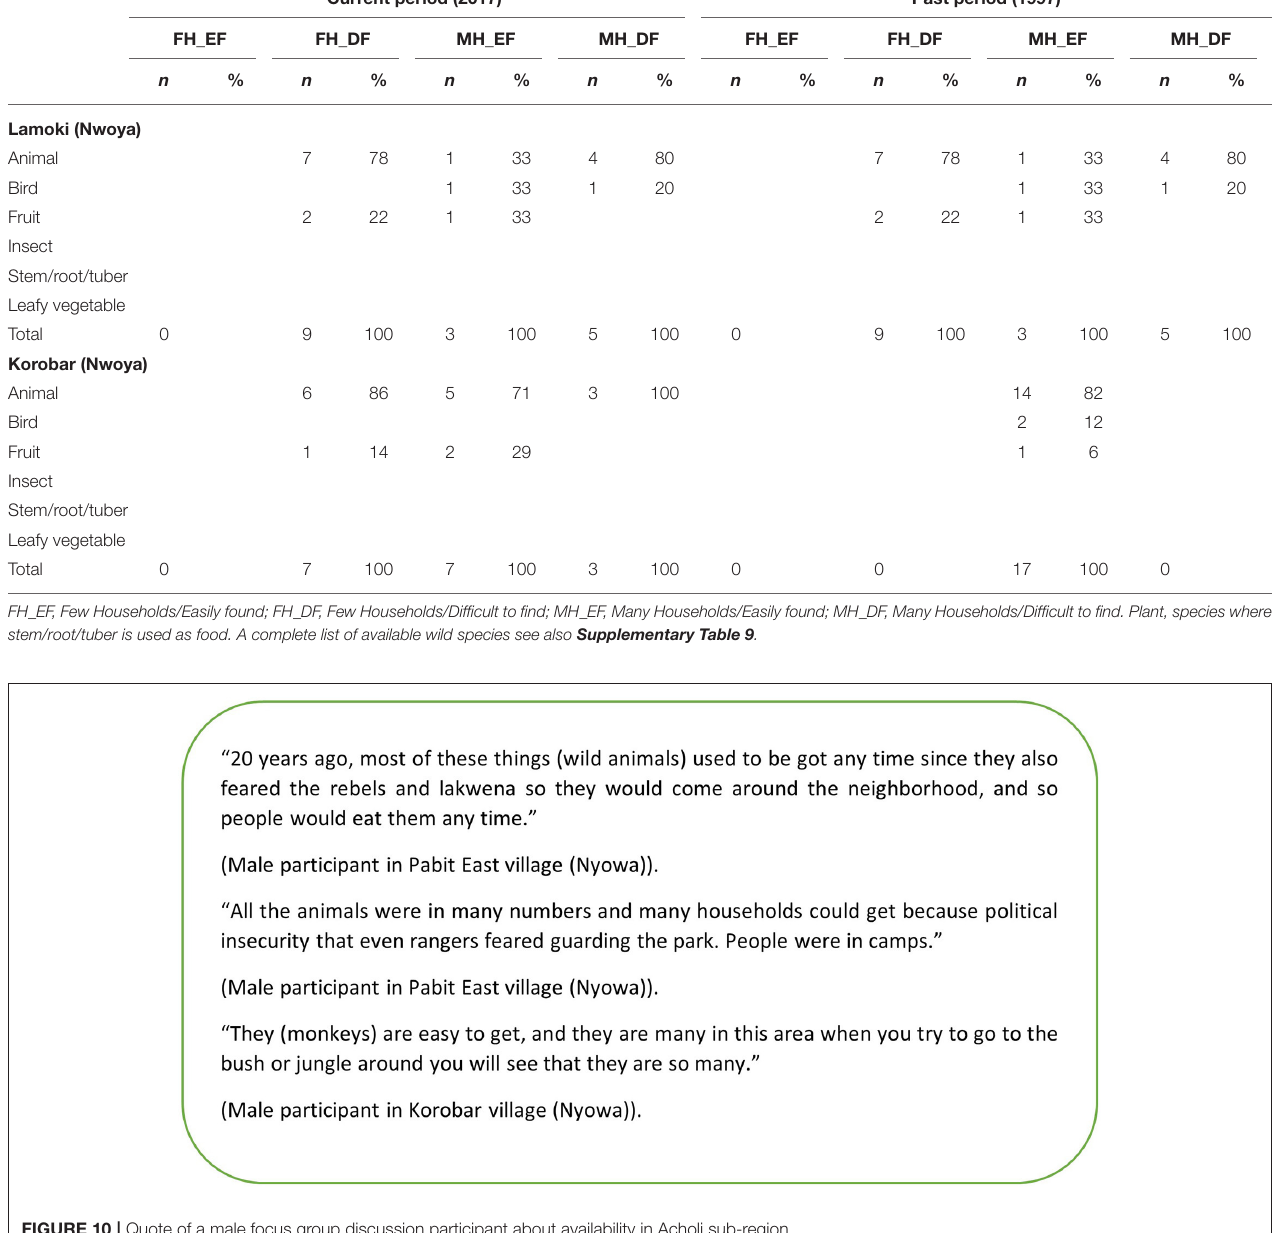
FIGURE 10 | Quote of a male focus group discussion participant about availability in Acholi